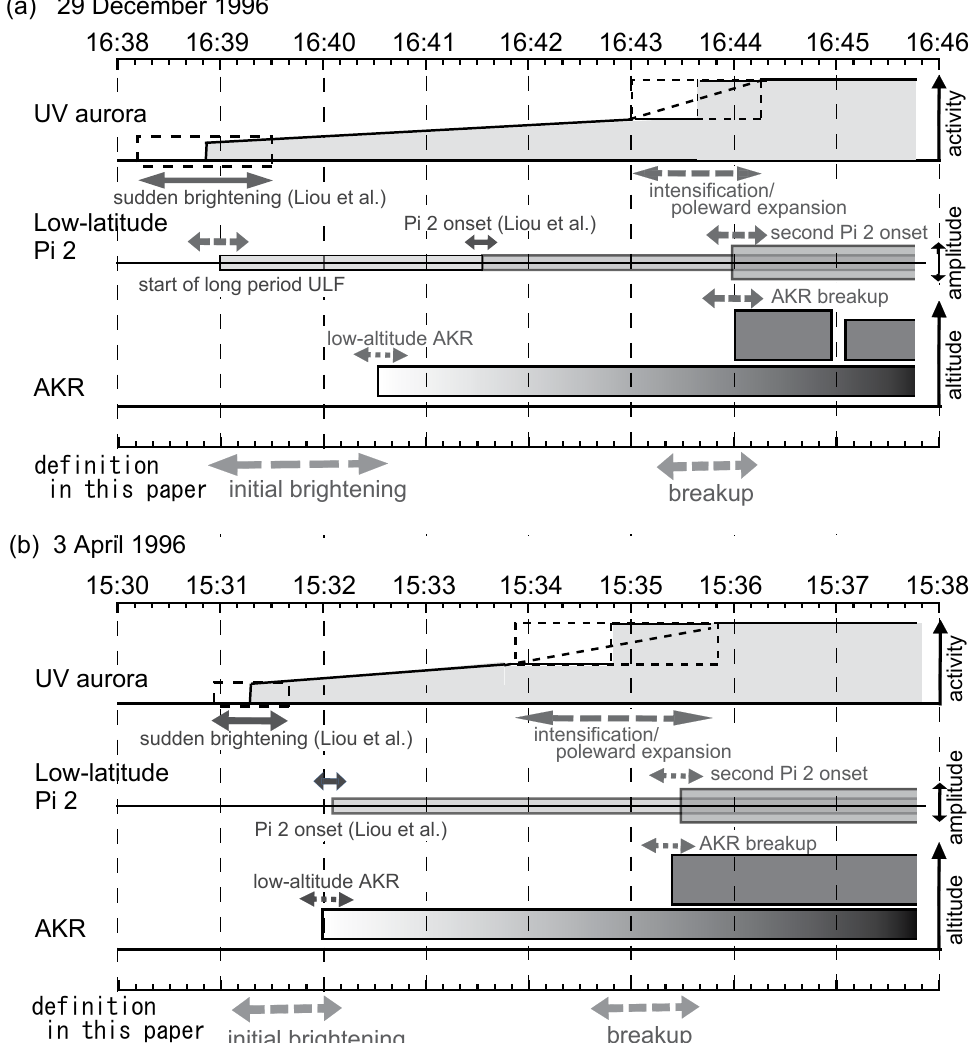
Fig. 7. Schematic illustrations of time sequence for (a) substorm on 29 December 1996 (see Fig. 4) and (b) substorm on 3 April 1996 (see Fig. 5). Vertical axes for UV aurora, Pi2, and AKR in each panel correspond to activity, amplitude, and altitude, respectively. Horizontal arrows indicate time tolerance for determining start time of each substorm